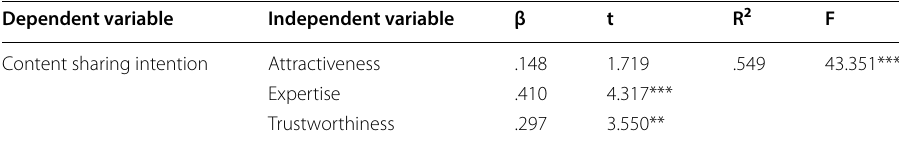
Table 10 Multiple regression result of vlogger’s attributes on content sharing intention— implicit exposure type